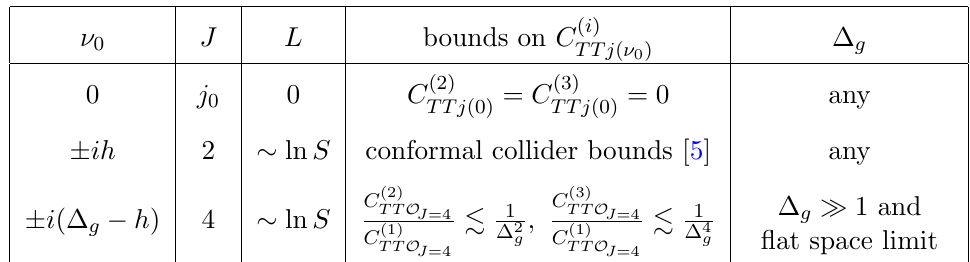
Table 1 . Summary of bounds on the leading Regge trajectory. For theories with a large (cid:1) g , we show that the bounds at (cid:23) 0 = 0 imply (1.4). In order to derive the bounds at (cid:23) 0 = given in (4.57), we have to impose in addition to large (cid:1) g the stronger condition that there is a well de(cid:12)ned (cid:13)at space limit. Analogous bounds are obtained for the OPE coe(cid:14)cient with two conserved